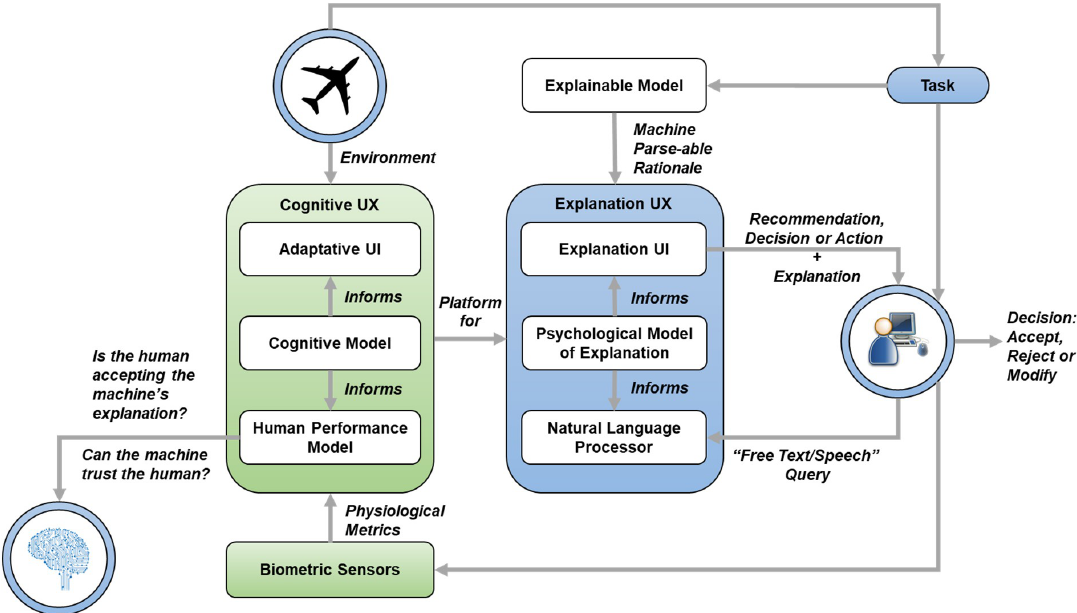
Figure 4. Combining cognitive and explanation user design interface (UX) principles (adapted from Reference [26]).